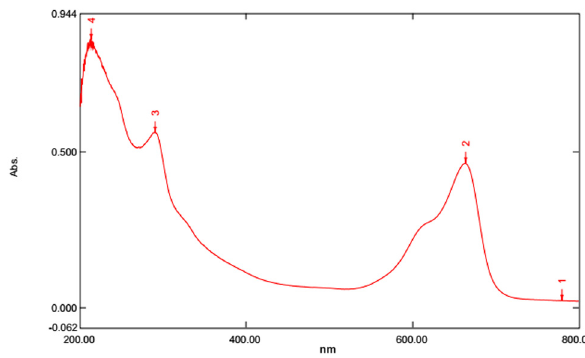
Figure 7: UV spectrum of ethanolic extract of D. viscosa .